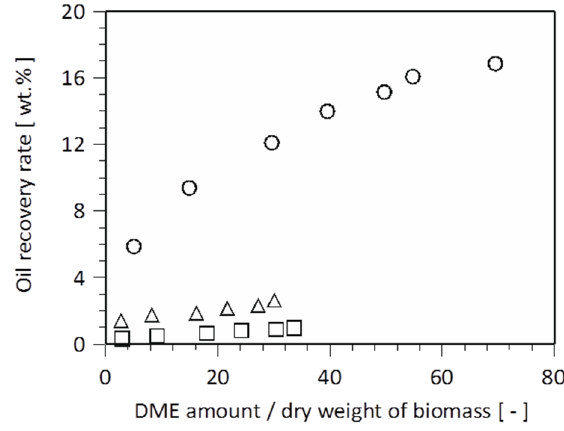
Figure 1. Oil recovery from IFWs using liquefied dimethyl ether (DME). The following IFWs were used: ○ coffee grounds; (cid:4574) rapeseed cake; □ soybean cake.